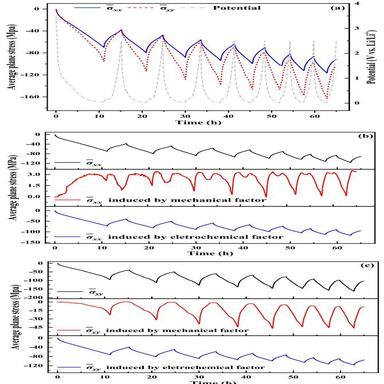
(a) The evolution of average plane stress, and effects of mechanical and electrochemical parts on the variation of (b) σxxand (c) σyyin the composite electrodes during electrochemical cycling.